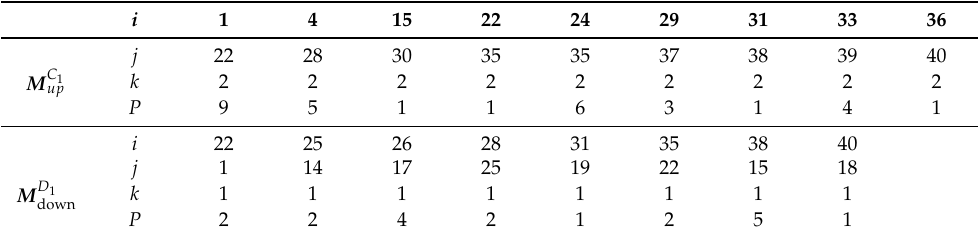
Table 7. Scheduling tasks of Elevator-CD in the first half